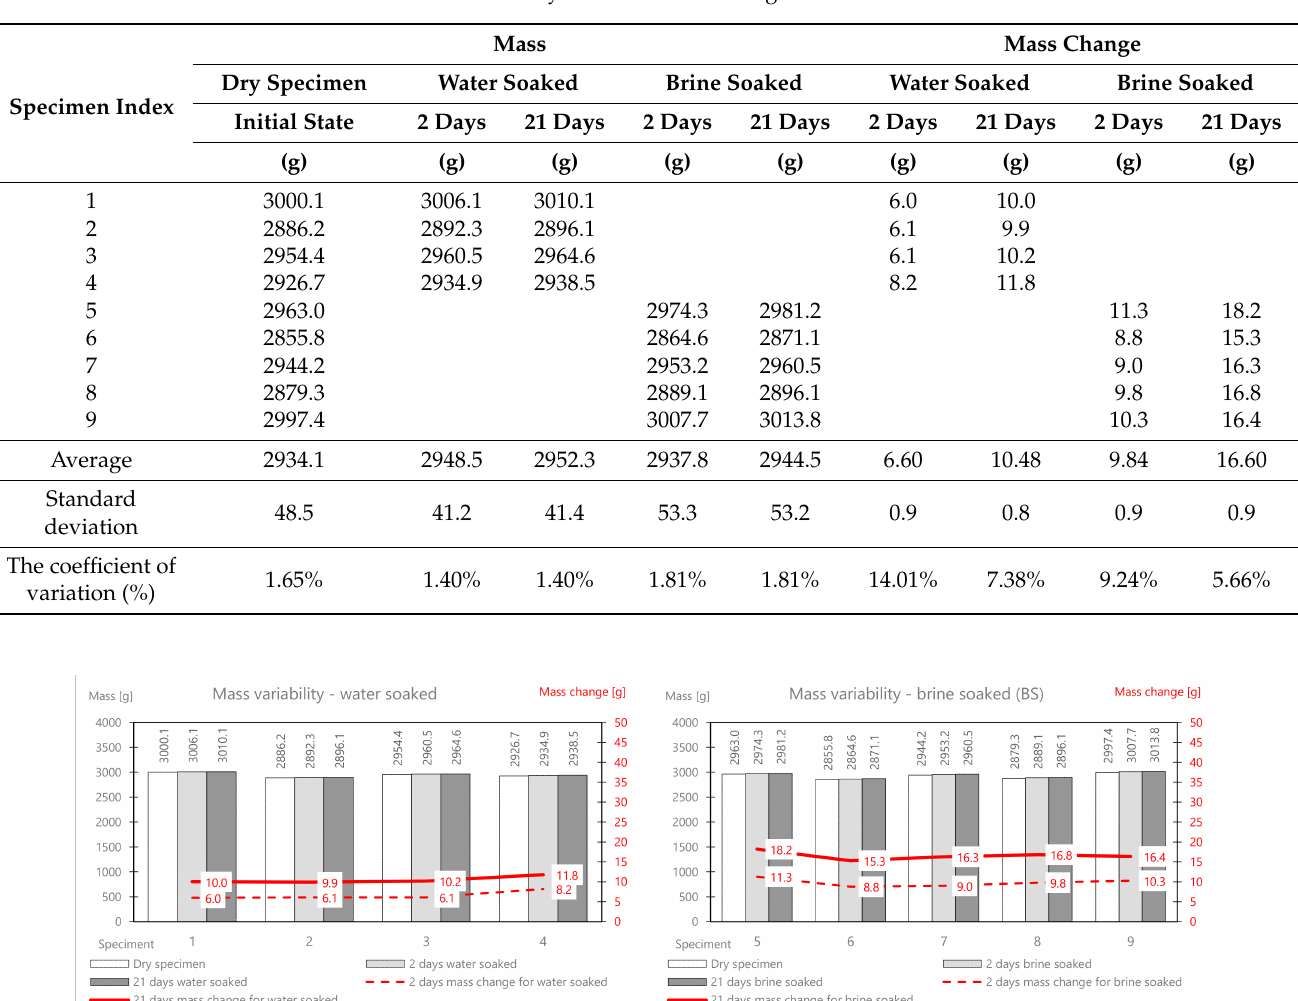
Table 3. Mass variability of AC11S via soaking in water and brine.